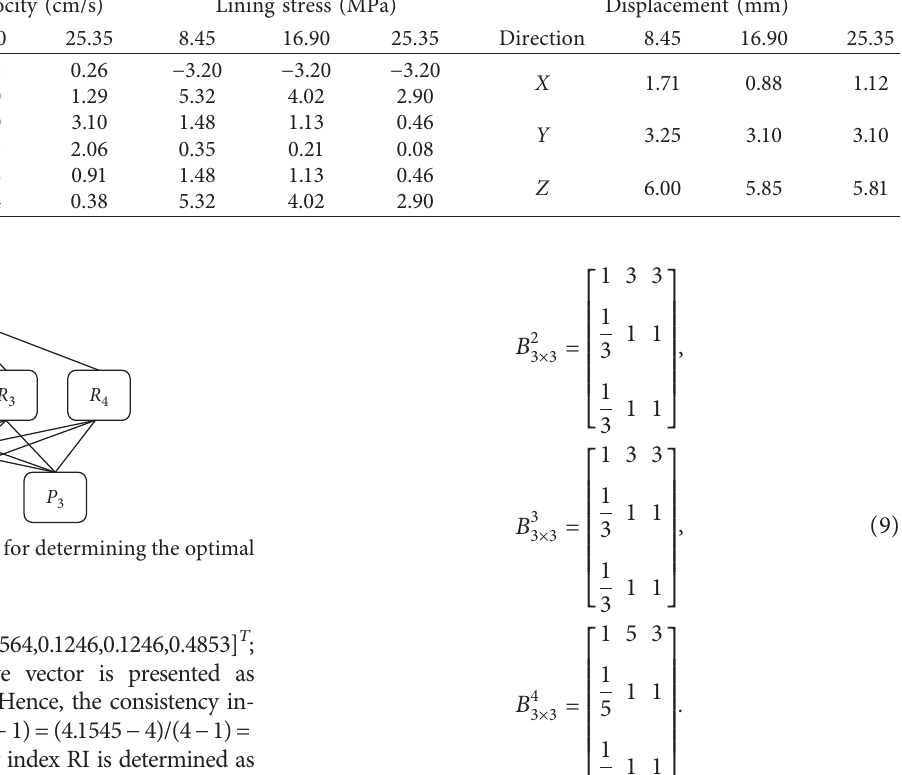
Table 7: The dynamic response of the existing tunnel to blasting under different clear distance conditions. Items